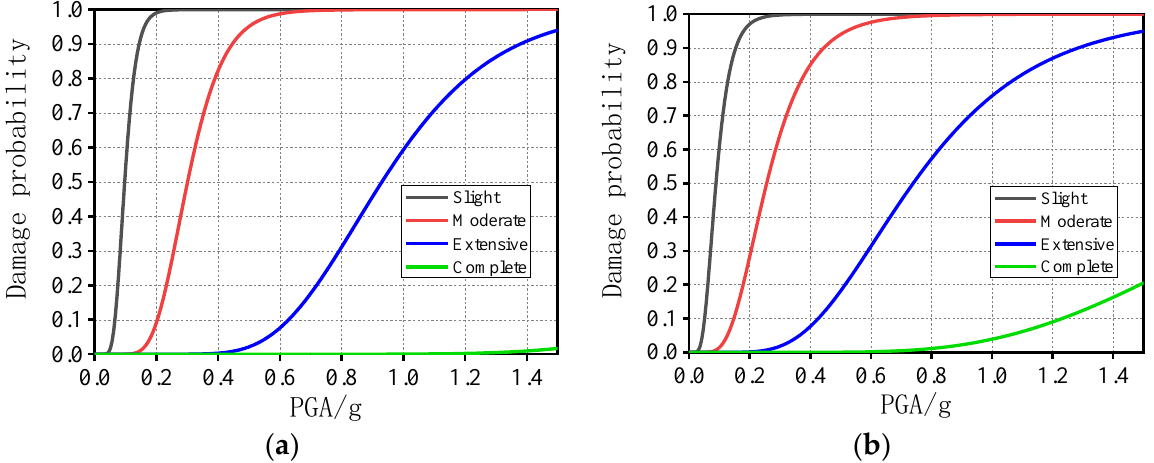
Figure 10. Acceleration-sensitive nonstructural components fragility curves: ( a ) CoSPSW, ( b ) SPSW.